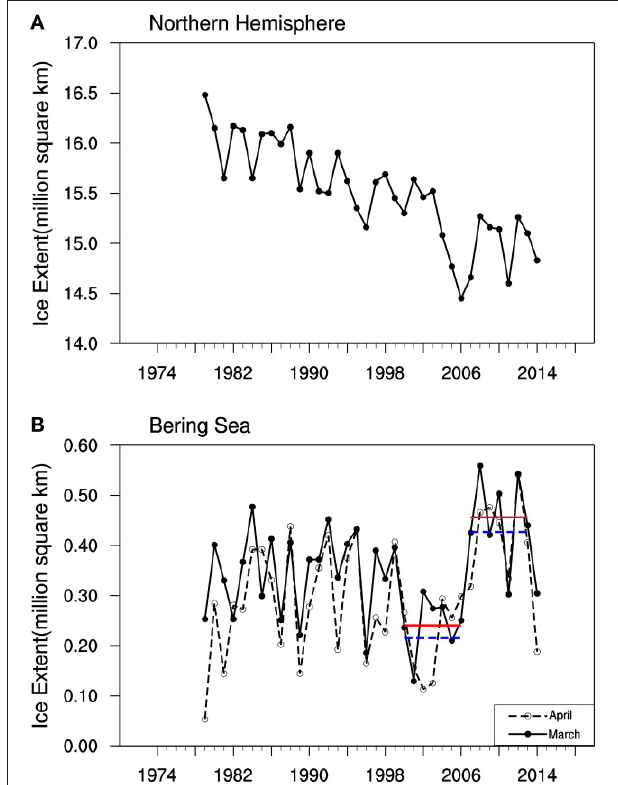
FIGURE 1 | Sea ice extent (10 6 km 2 ) for the whole Northern Hemisphere in March (A) and the region of 56–62 ◦ N and 180–160 ◦ W of the Bering Sea in March (solid lines) and April (dashed lines) (B) based on NSIDC data. The horizontal lines in (B) denote the average value over the respective